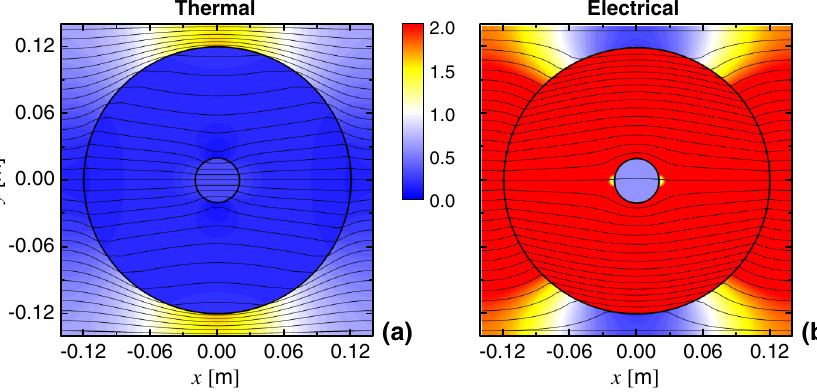
FIG. 6. As in Fig. 5, but for a shell (of the same size) made of stainless steel ( κ ¼ 16 . 3 W = ð mK Þ , σ ¼ 1 . 42 × 10 6 S = m)